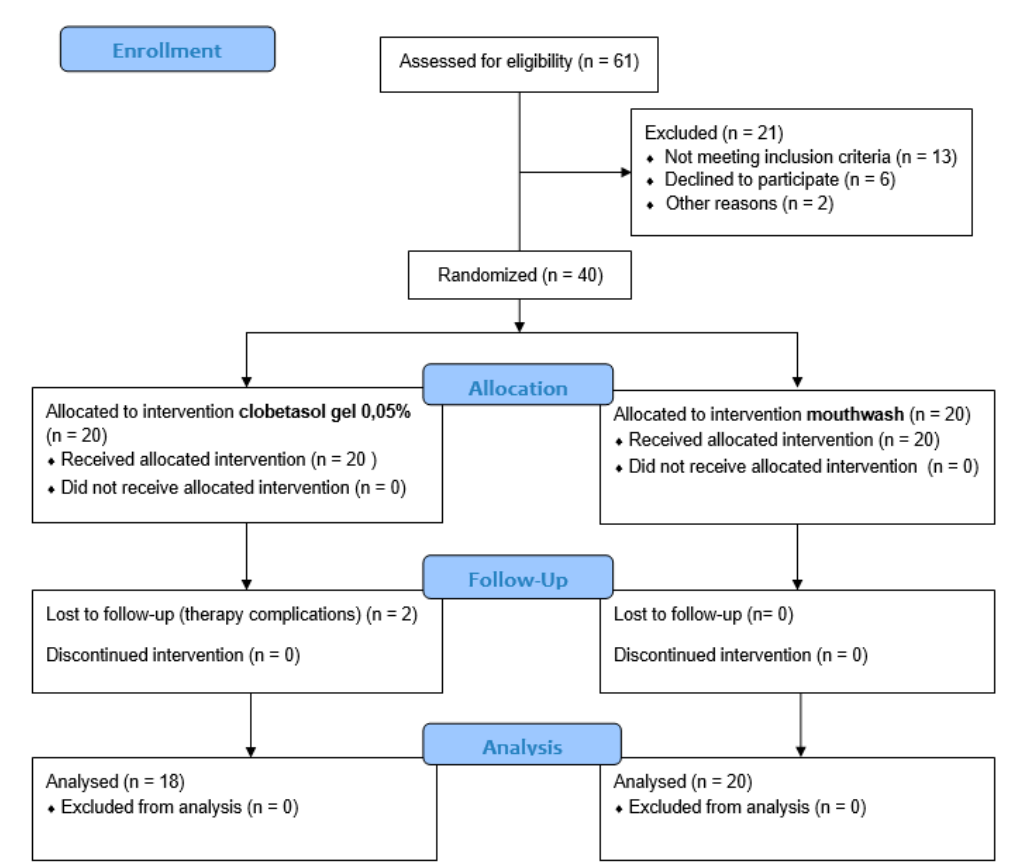
Figure 1. Flow chart of the study.